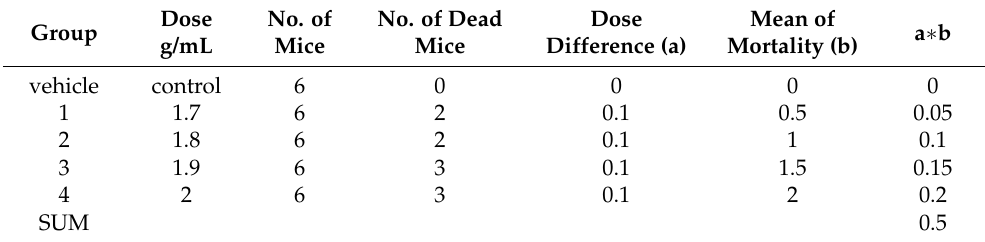
Table 7. Results for LD 50 using the Karber method.